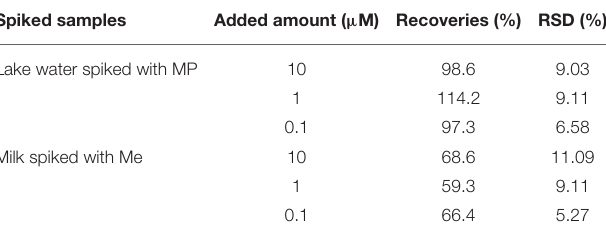
TABLE 2 | Recovery studies of methyl parathion in spiked lake water samples and melamine in spiked milks samples. Spiked